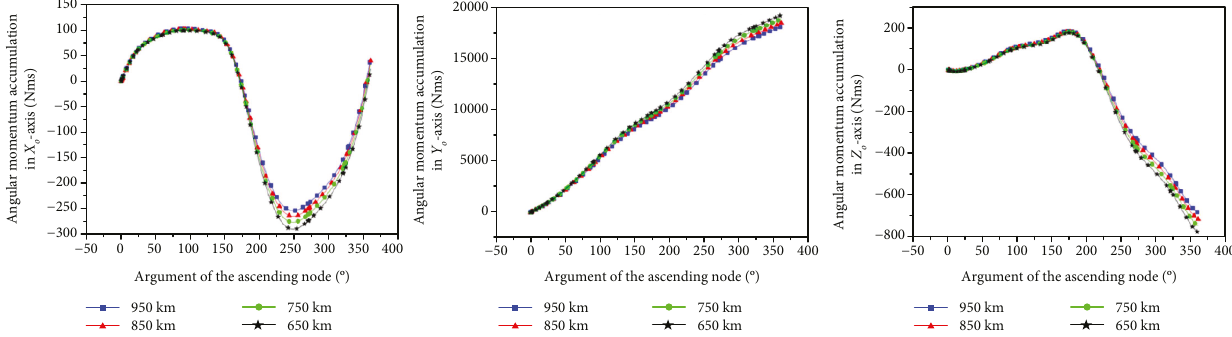
Figure 6: Magnetic momentum accumulation (orbital coordinates) in di ff erent circular orbit altitudes under equation (10) (example